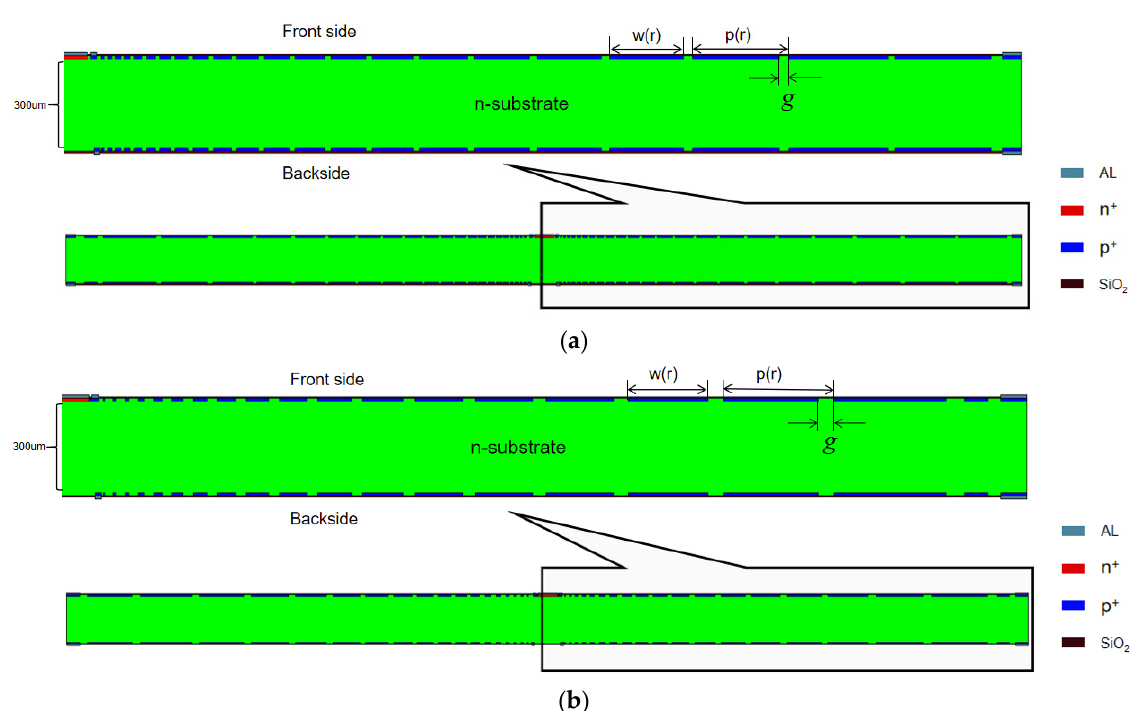
Figure 3. Detector simulation X = 0 (Y-Z positive plane) cross section: ( a ) gap 10 µm; ( b ) gap 25 µm.